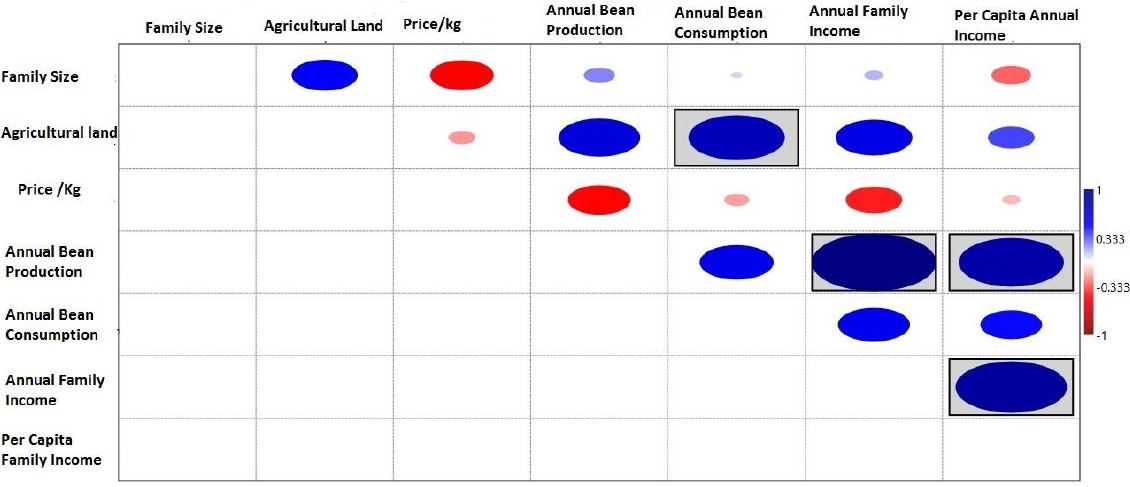
Figure 2. Pearson’s ( p < 0.05) linear correlation among the common bean production, income and socioeconomic variables.